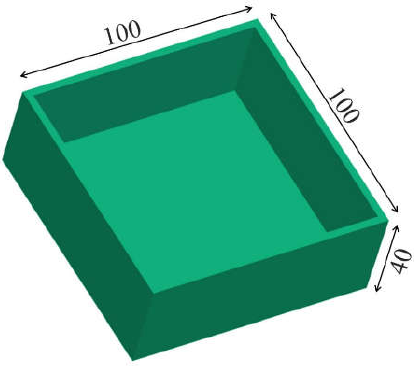
Figure 1. Geometry of the investigated box shaped part with global dimensions in mm.